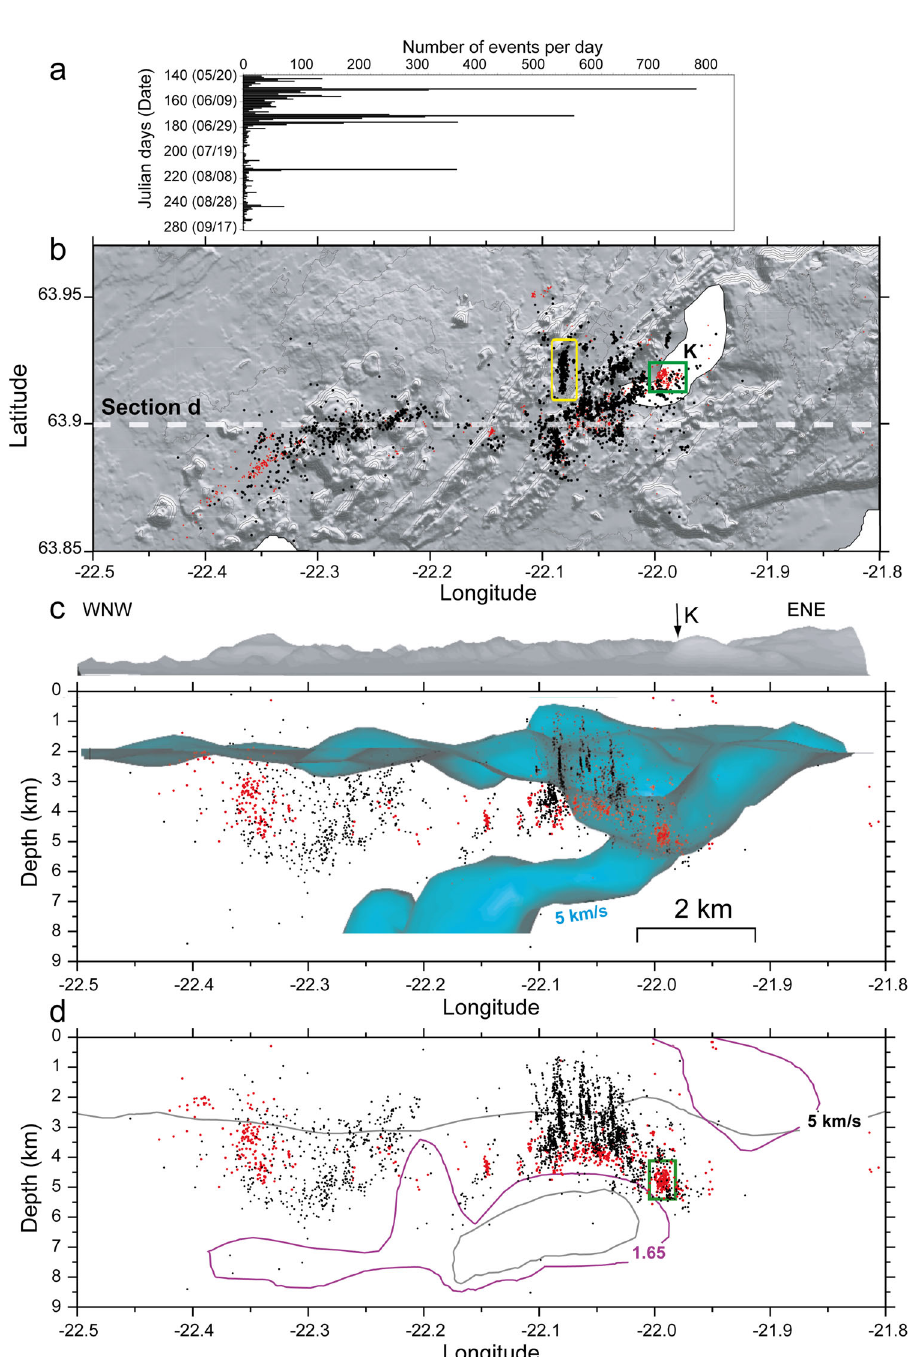
Fig. 2 Seismicity distribution during the 2005 and 2009 experiments. a Time distribution of the seismicity from the 2009 experiment. K: lake Kleifarvatn. The yellow rectangle is the location of the ~NS-trending Nupshlidarhals swarm (see Fig. 3). b Map of the epicenters. Red and black dots are the events recorded during the 2005 23 and 2009 experiment, respectively. Green square indicates the location of the 2005 swarms used for permeability calculations (see Fig. 1 in Supplementary Material). The white dashed line shows the location of the cross section represented in ( d ); c 3D view of the low Vp anomaly (Vp = 5 km/s contour). d Hypocenters projected along an East – West cross-section (location in a ). The black and purple lines represent the Vp = 5 km/s and Vp/Vs = 1.65 ratio contours,